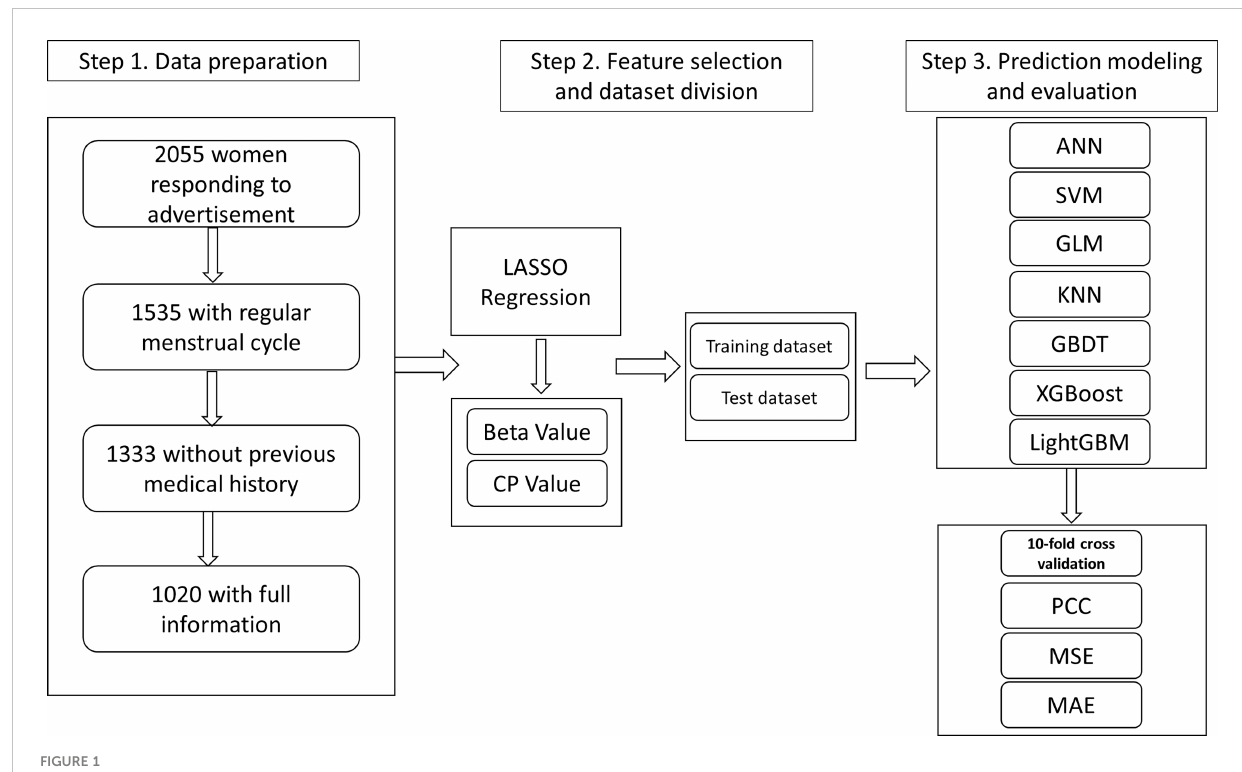
FIGURE 1 The fl owchart of the study